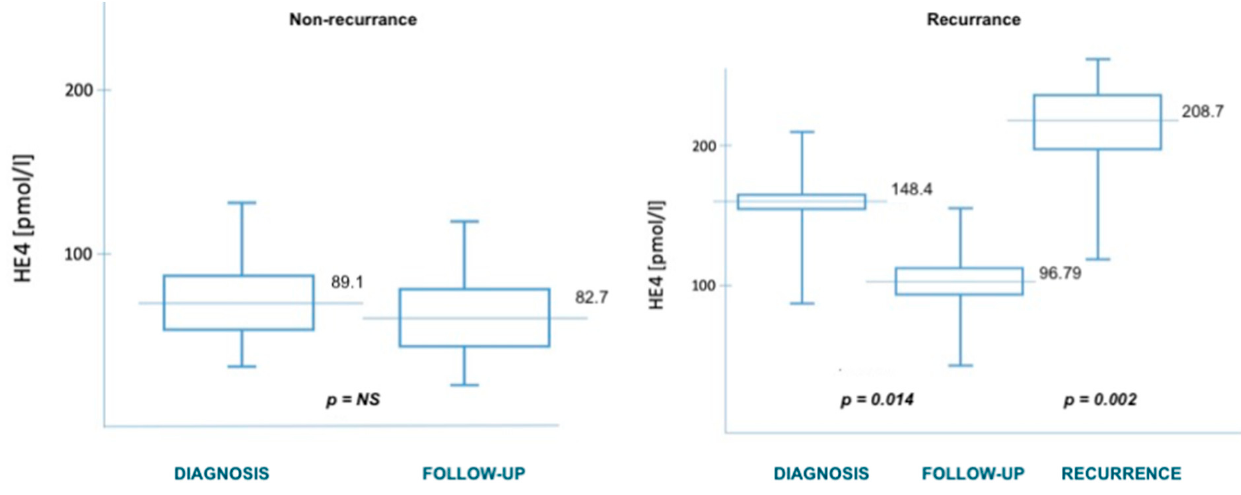
Figure 4. HE4 levels in relation to recurrence.